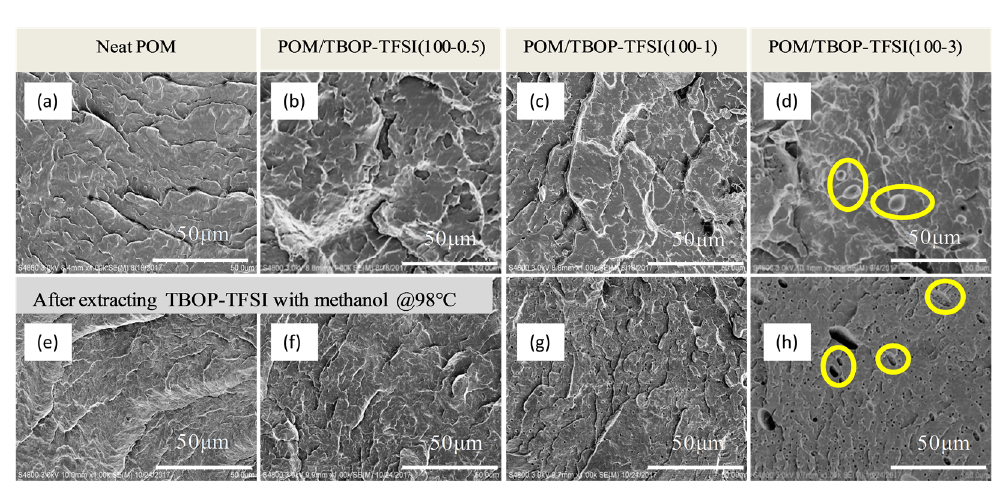
Figure 1. SEM images of fracture surface morphologies of polyoxymethylene (POM)/tributyl(octyl)phosphonium bis(trifloromethanesulfonyl) imide (TBOP-TFSI) blends with indicated TBOP-TFSI loadings before ( a – d ) and after extracting with methanol ( e – h ).